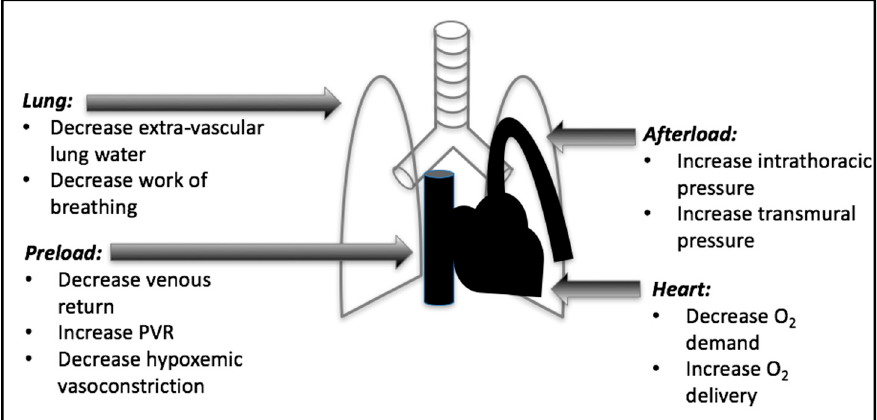
Figure 1. Summary of the effects of positive end expiratory pressure (PEEP).